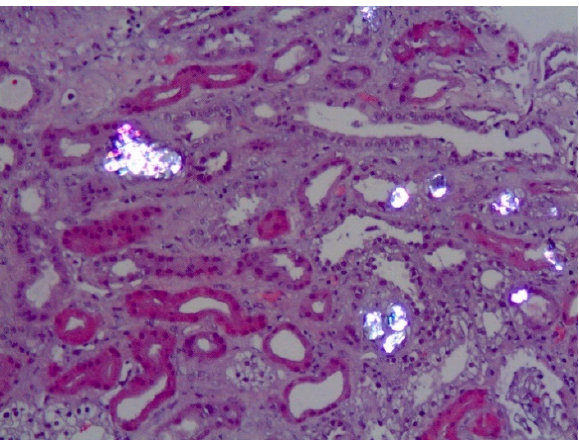
Figure 2. Calcium oxalate crystals (bright birefringent crystals) are shown in a kidney biopsy of a PH1 patient with chronic renal disease. Note the tubular damage and atrophy, interstitial inflammation and fibrosis secondary to calcium oxalate deposits.